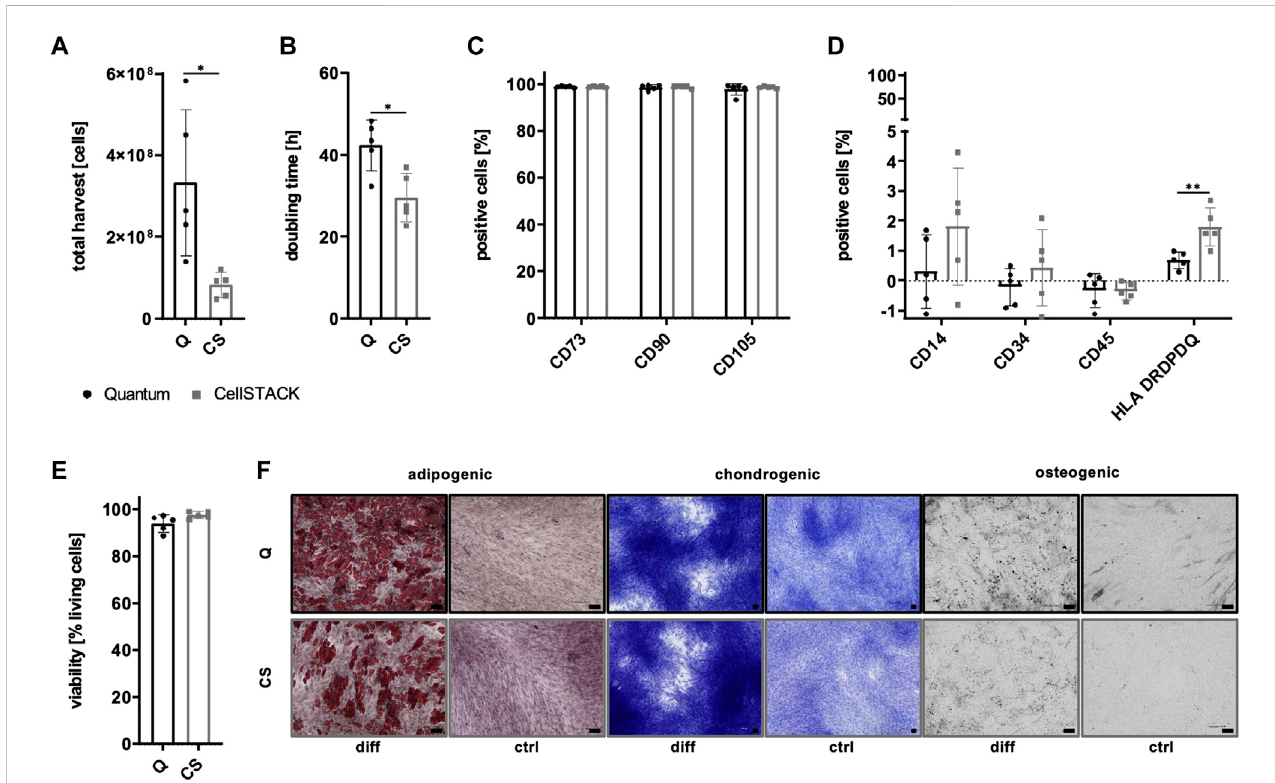
Expansion parameters and characteristics of MSCs after Quantum- and CellSTACK-based culture. MSCs were grown in α MEM+8% PL in a CP-coated Quantum hollow fi ber bioreactor (Q; black) or in conventional cell culture in a CellSTACK (CS; gray) for P1. The expansion parameters total harvest (A) and doubling time (B) were determined after the harvesting of cells. The expression of identity markers CD73, CD90, and CD105 (C) and purity markers CD14, CD34, CD45, and HLA DRDPDQ (D) were analyzed by fl ow cytometry. (E) Viability of cells was determined by trypan blue staining. (F) Harvested MSCs were differentiated into cells of adipogenic, chondrogenic, and osteogenic lineages. For this, the cells were grown in speci fi c differentiation media (diff) or in control media α MEM+20% FBS (ctrl) lacking differentiation-inducing substances. Adipogenic differentiation was veri fi ed by Oil Red O and hematoxylin staining, chondrogenic differentiation was demonstrated by methylene blue staining and osteogenic differentiation was proven by activity of alkaline phosphatase using BCIP/NBT substrate. Pictures were taken with 4 times (chondrogenic) and 10 times magni fi cation (adipogenic and osteogenic), respectively. The black scale bars indicate 100 µm. Data are presented as mean ± SD, and N ≥ 4 independent experiments were performed. Representative images are depicted for differentiation assays. Statistically signi fi cant differences are depicted as follows: *: p < 0.05, **: p <